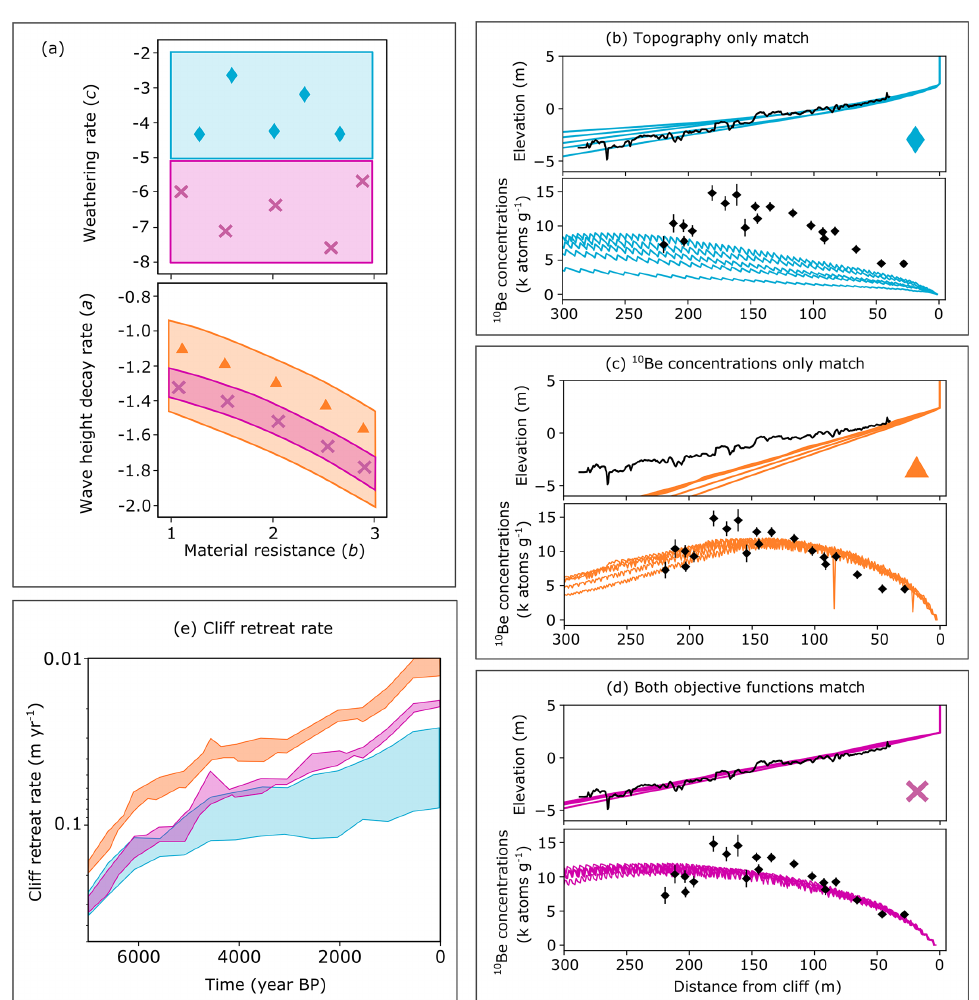
Figure 11. Objective function surface at Bideford (a) for the parameters material resistance ( b ), material weathering rate ( c ), material resistance ( b ), and wave height decay rate ( a ). The blue shaded region (a) shows where in the parameter space the modelled topographic profile alone can match measured data. Blue diamonds (a) correspond to example model results shown in (b) . The orange shaded region (a) shows where in the parameter space the modelled 10 Be concentration profile alone can match measured data. Orange triangles (a) correspond to example model results shown in (c) . The pink shaded region (a) shows where in the parameter space both the modelled topographic profile and 10 Be concentration profile can match measured data. Pink crosses (a) correspond to example model results shown in (d) . Cliff retreat rates (myr − 1 ) on a log scale for each set of model examples are shown in (e) . Model results are from the 50%–50% weighted Pareto set